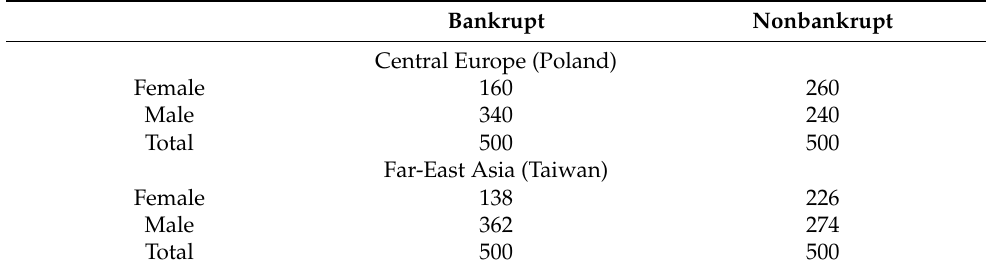
Table 1. Distribution of consumers’ gender in two testing samples. Source: based on own